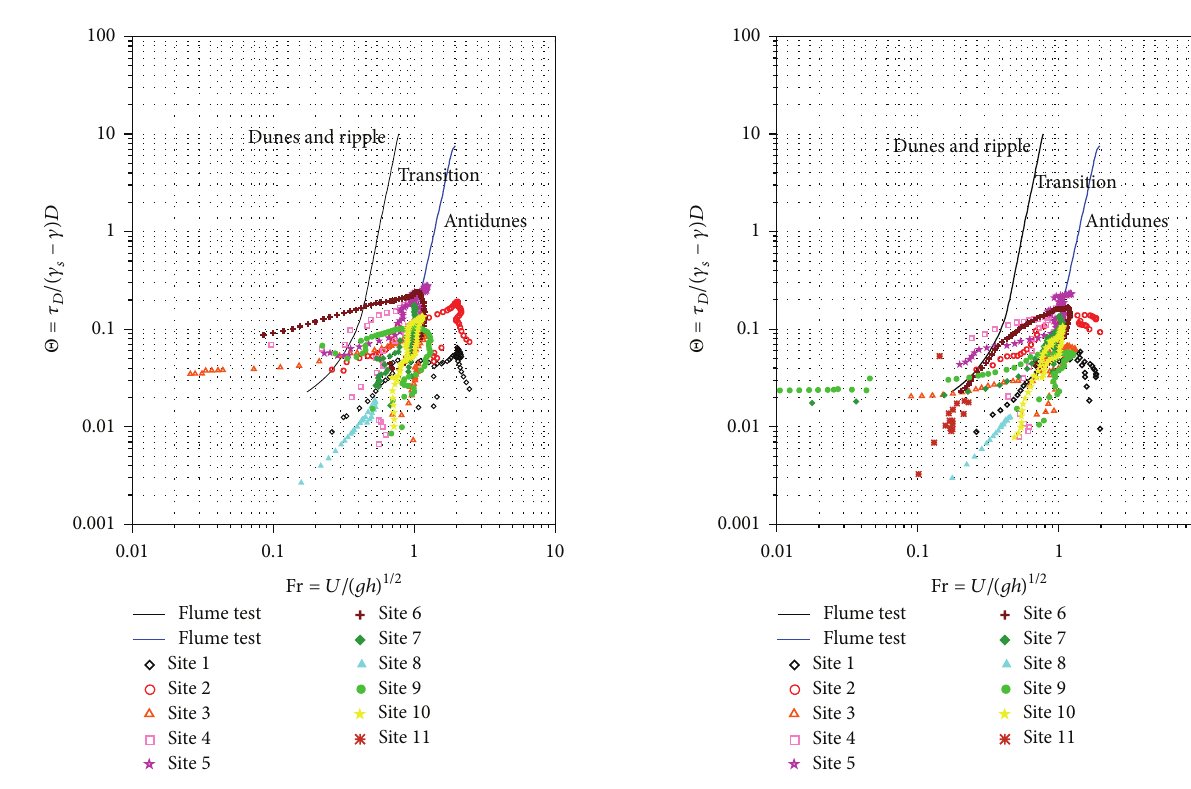
Figure 13: Shields number versus Froude number for Shi-Wen River using 2-year return period. (𝜏 𝑏 /(𝛾 𝑠 − 𝛾)𝐷) , in which 𝜏 𝑏 is bed shear stress, 𝛾 𝑠 and 𝛾 aresedimentandfluiddensities,respectively,and 𝐷 is the grain size to be moved multiplied by acceleration due to gravity. The parameter ( 𝑈/√𝑔ℎ ) represents the Froude number, in which 𝑈 is the flow velocity and 𝑔 and ℎ are the acceleration due to gravity and flow depth,